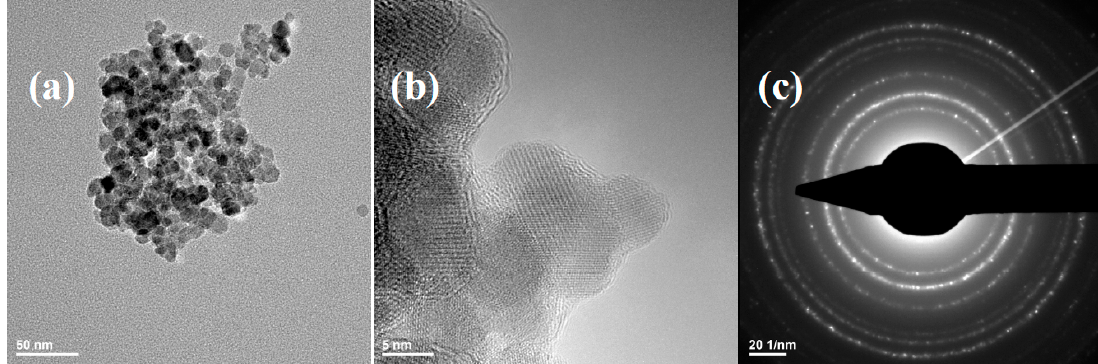
Figure 2. Transmission electron microscopy (TEM) image ( a ), HR ‐ TEM (high resolution electron microscopy) image ( b ) and SAED (selected area diffraction) pattern ( c ) of Fe 3 O 4 @PAT.